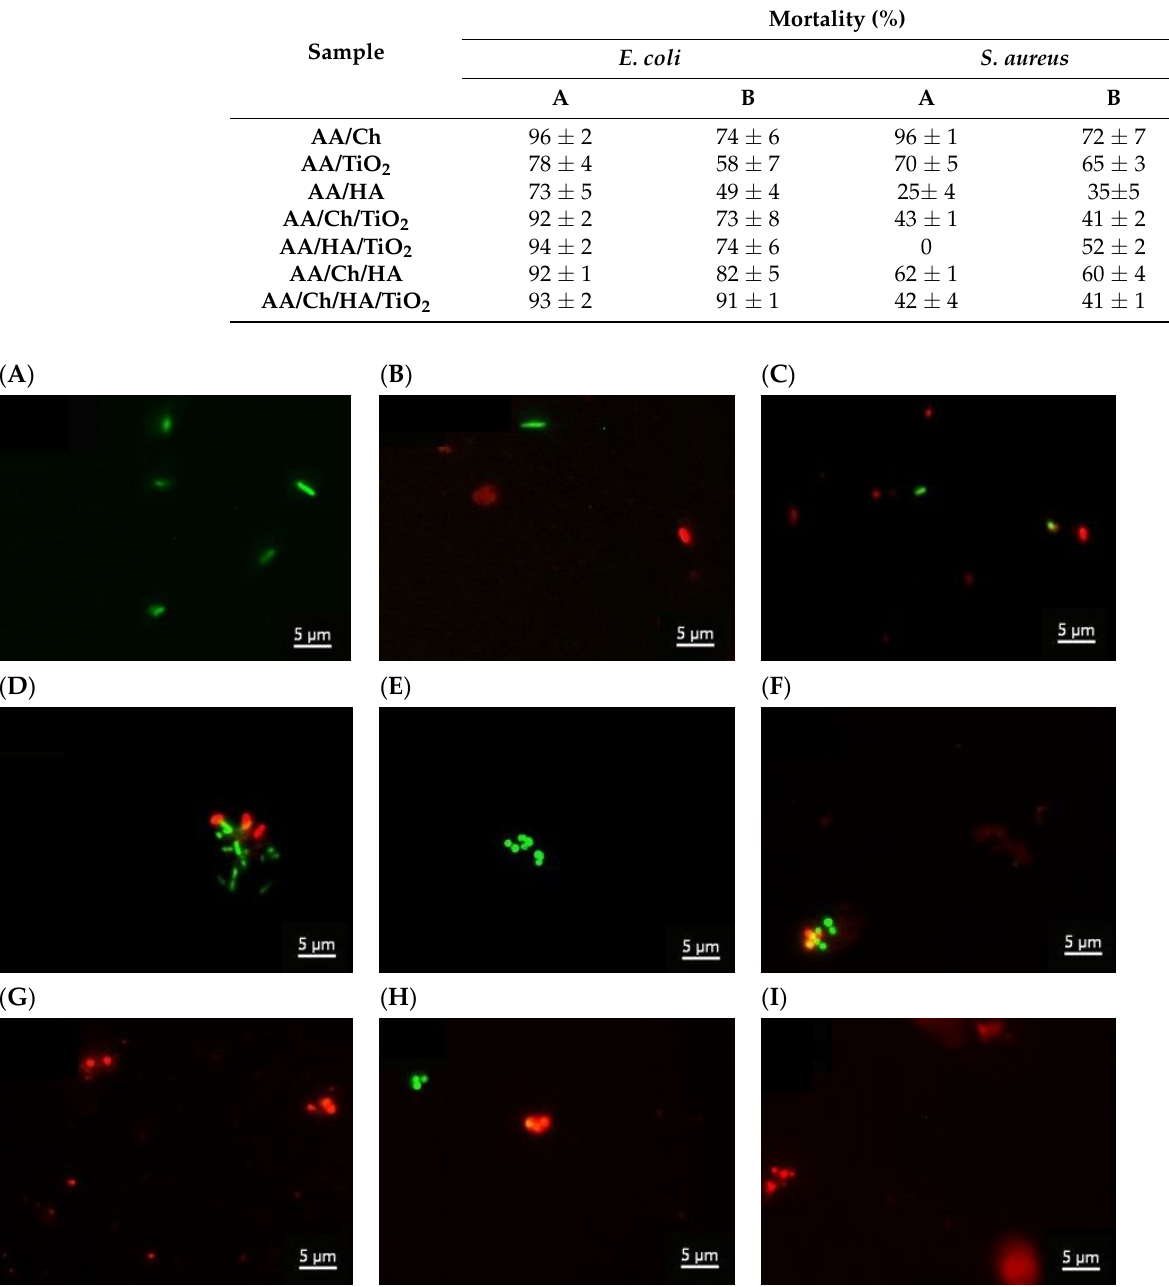
Table 5. Mortality (%) of S. aureus and E. coli in the presence of the compounds measured using a colony-counting assay (A) and live/dead staining with fluorescent intensity measurements (B).